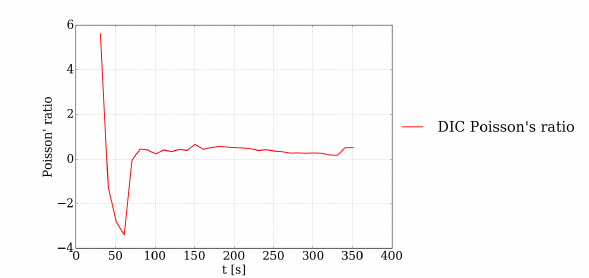
Figure 17: Poisson’s ratio trend for sample n.